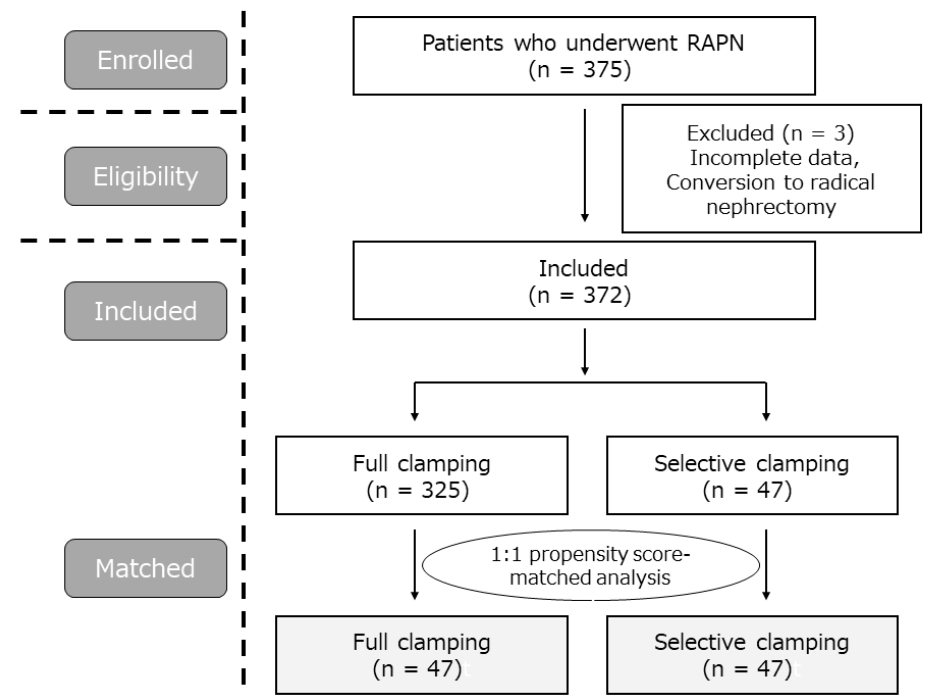
Figure 1. Flowchart of the patients in the